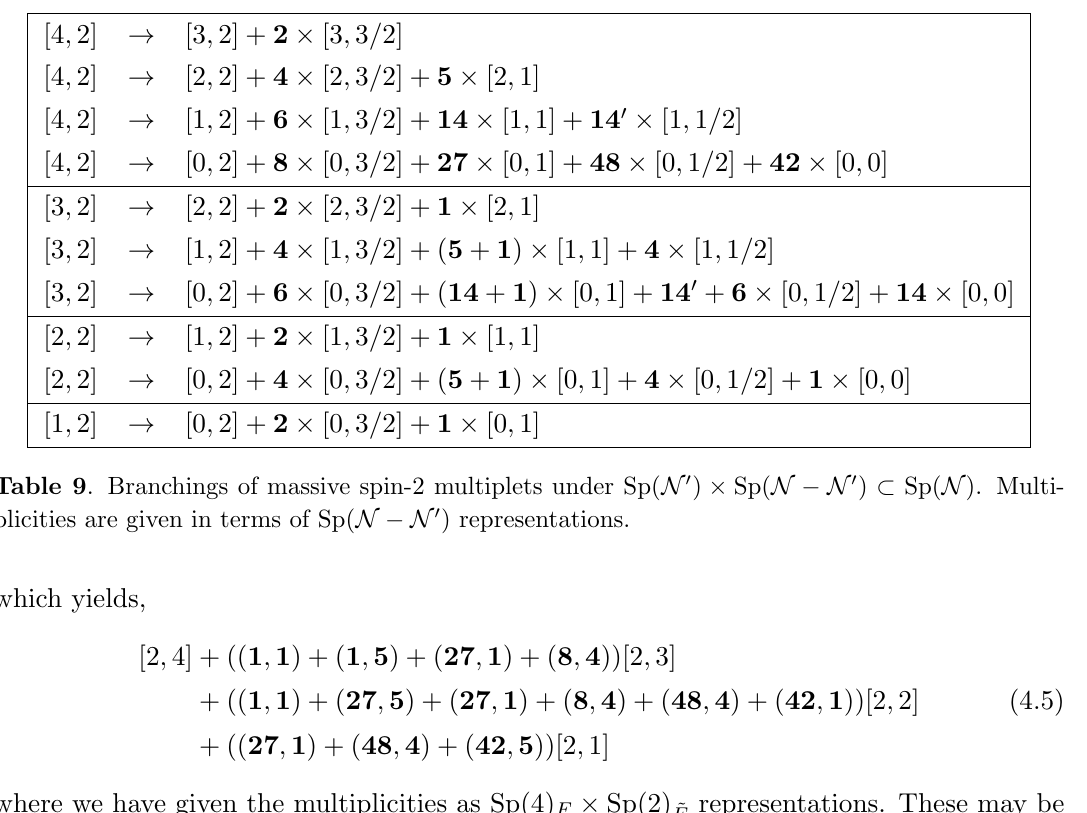
Table 8 . Some relevant products of massive long multiplets.